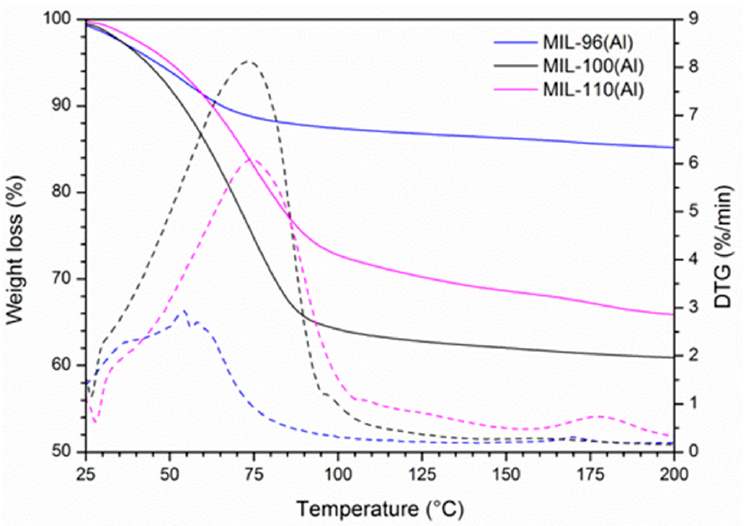
Figure 2. TG (solid) and DTG (dash) curves of MIL-96(Al), MIL-100(Al) and MIL-110(Al) materials.